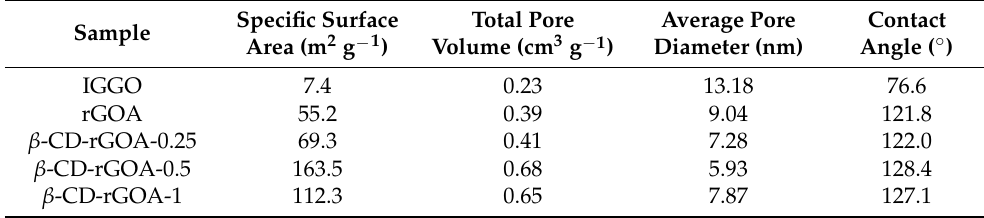
Figure 2. Comparison of the adsorption–desorption isotherms of nitrogen ( a ) and pore size distribution ( b ) by IGGO, rGOA, and β -CD-rGOA-0.5. Table 1. Properties of IGGO and β - CD-rGOAs.